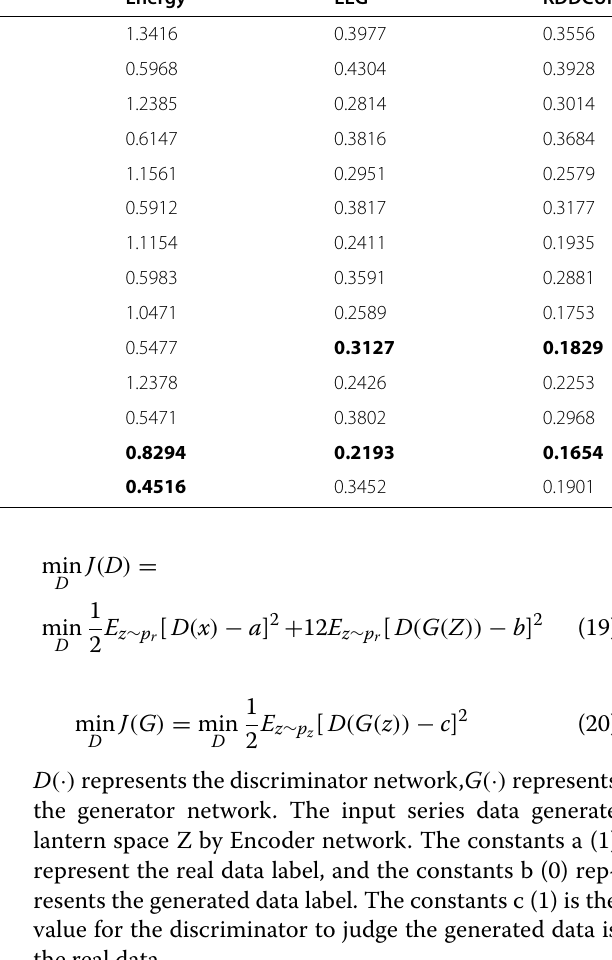
Table 1 The MAE and RMSE indexes of time series prediciton over the five datasets( (cid:2) =50) Models